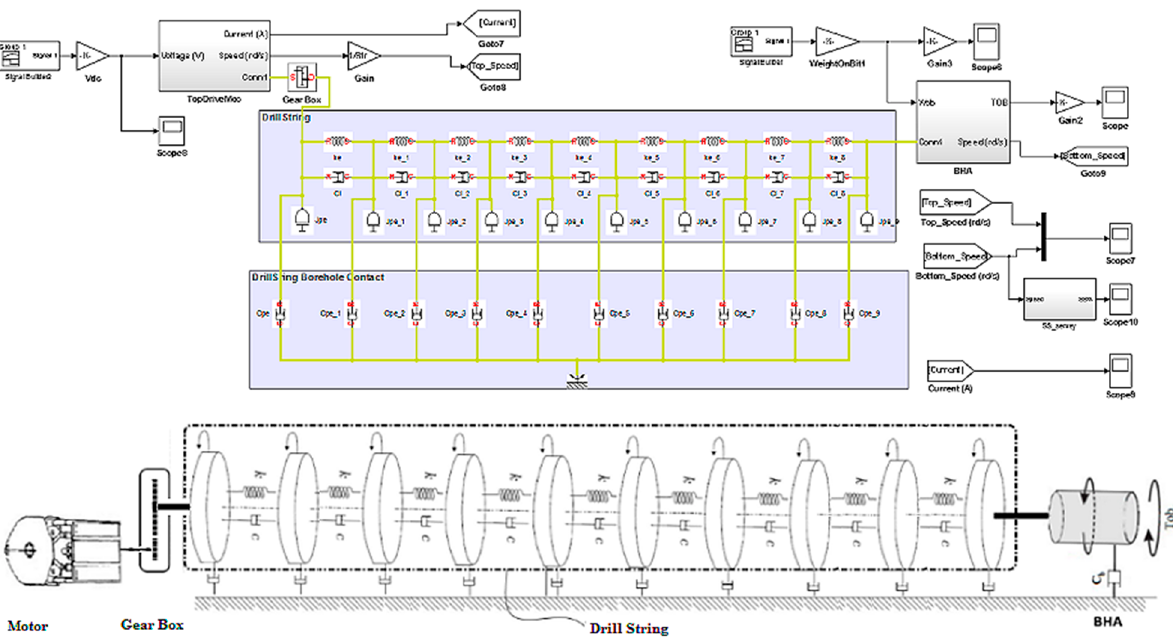
Figure 3. SimScape model of the drilling system with 10 degrees of freedom [24].